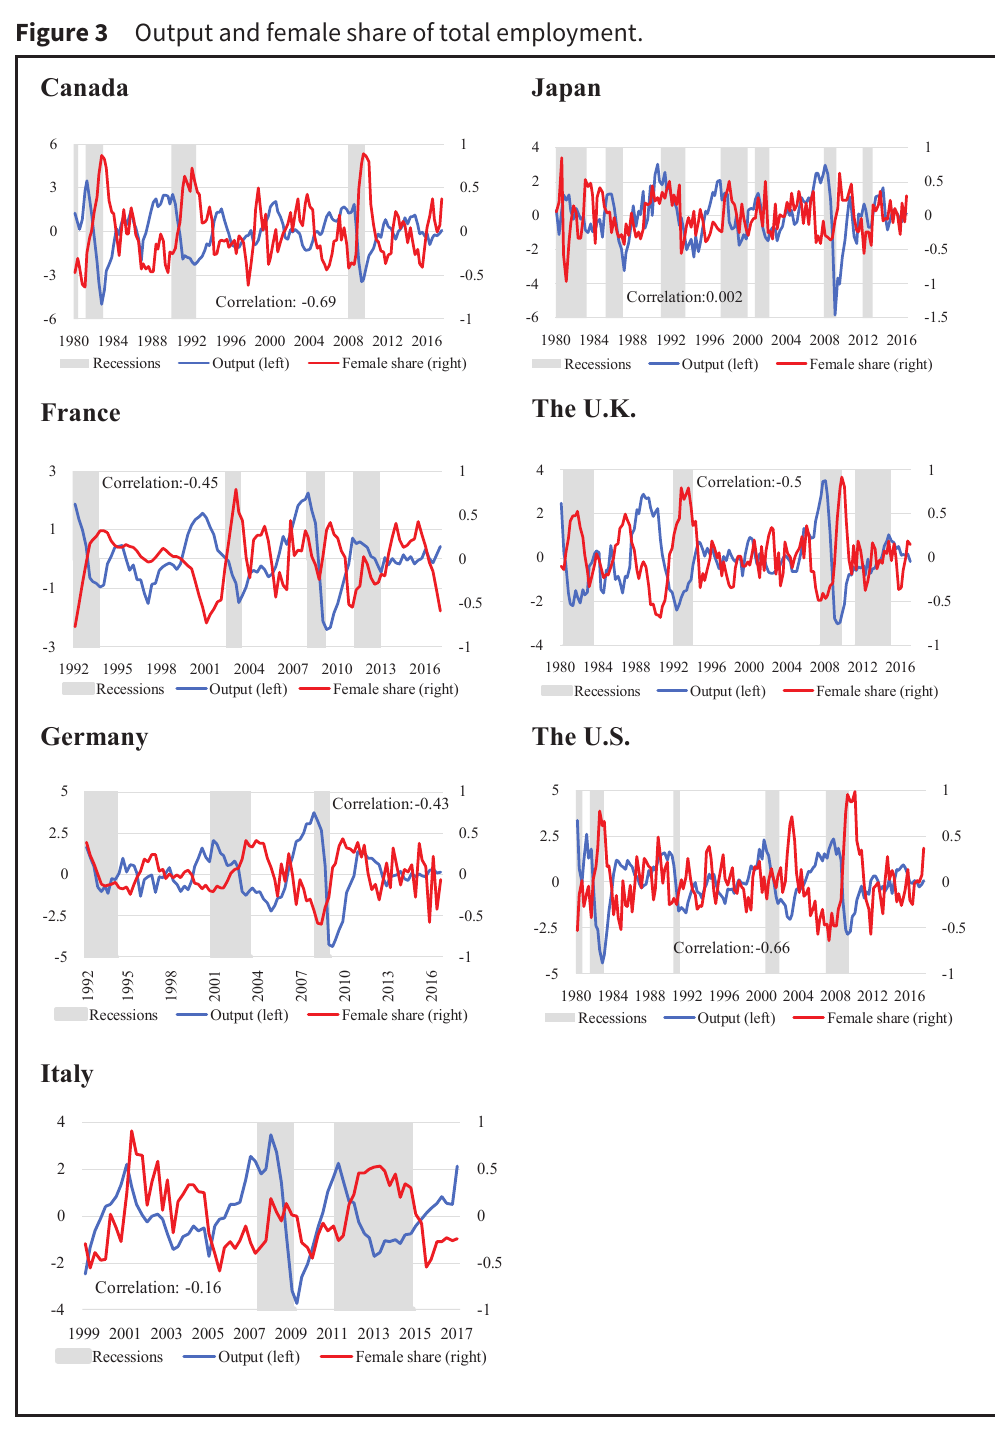
Figure 3 Output and female share of total employment.